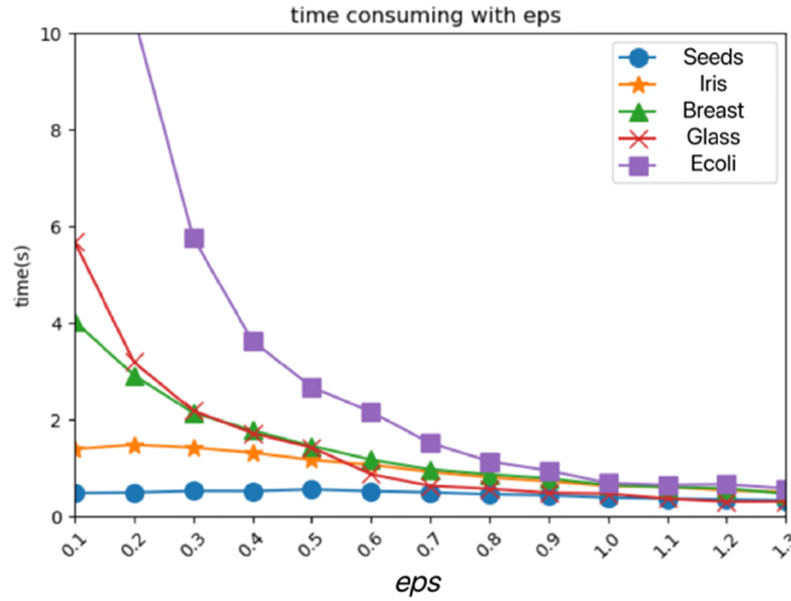
Figure 6. Parameter eps and time consumption of PRI-MFC algorithm.